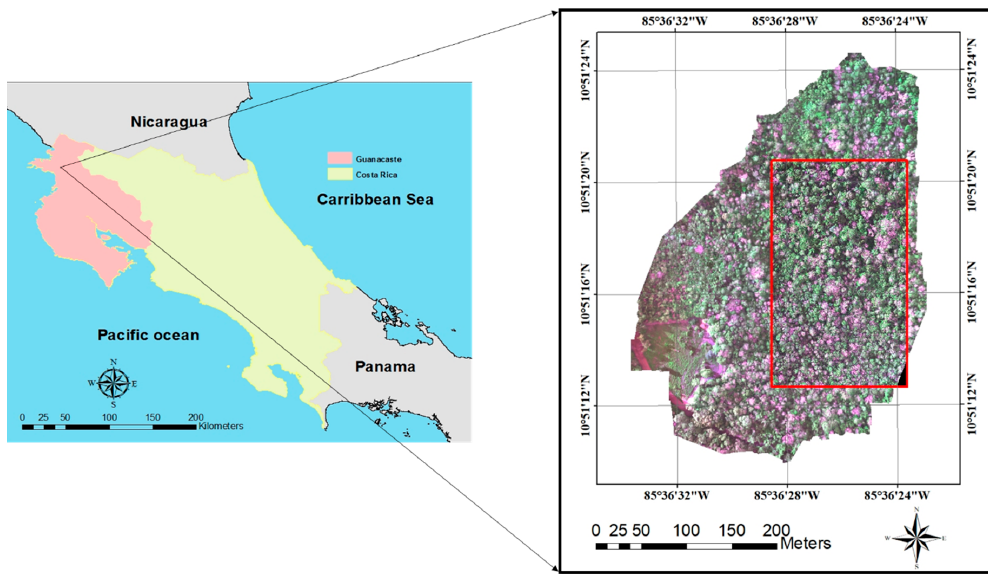
Figure 1. The study area in the province of Guanacaste, Costa Rica. The inset map shows the study area as a red rectangle overlain on a red, green, and blue (R: 668 nm, G: 560 nm, B: 475 nm) composite image acquired by an unmanned aerial vehicle (UAV) with a spatial resolution of 0.15 m.